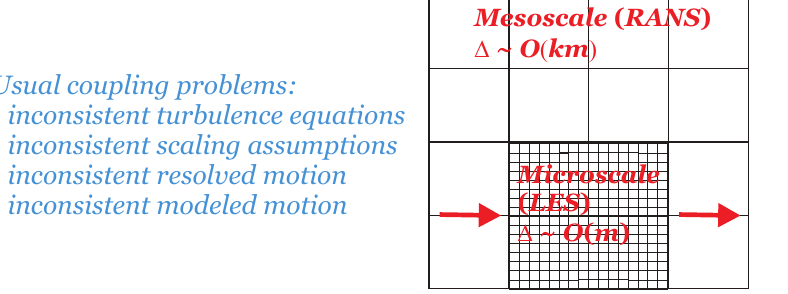
Figure 3. Typical problems related to the coupling of mesoscale (RANS) and microscale (LES) methods, where ∆ refers to the characteristic grid size used in